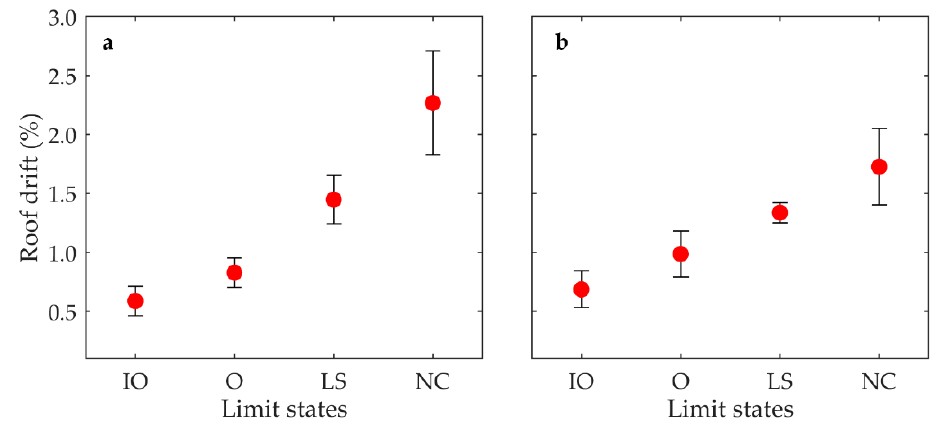
Figure 10. Roof drift and limit state relationship according to the triggered global failure mode (red dots are average drifts and back lines show max and min values): ( a ) α = 2.0; ( b ) α = 0.5.